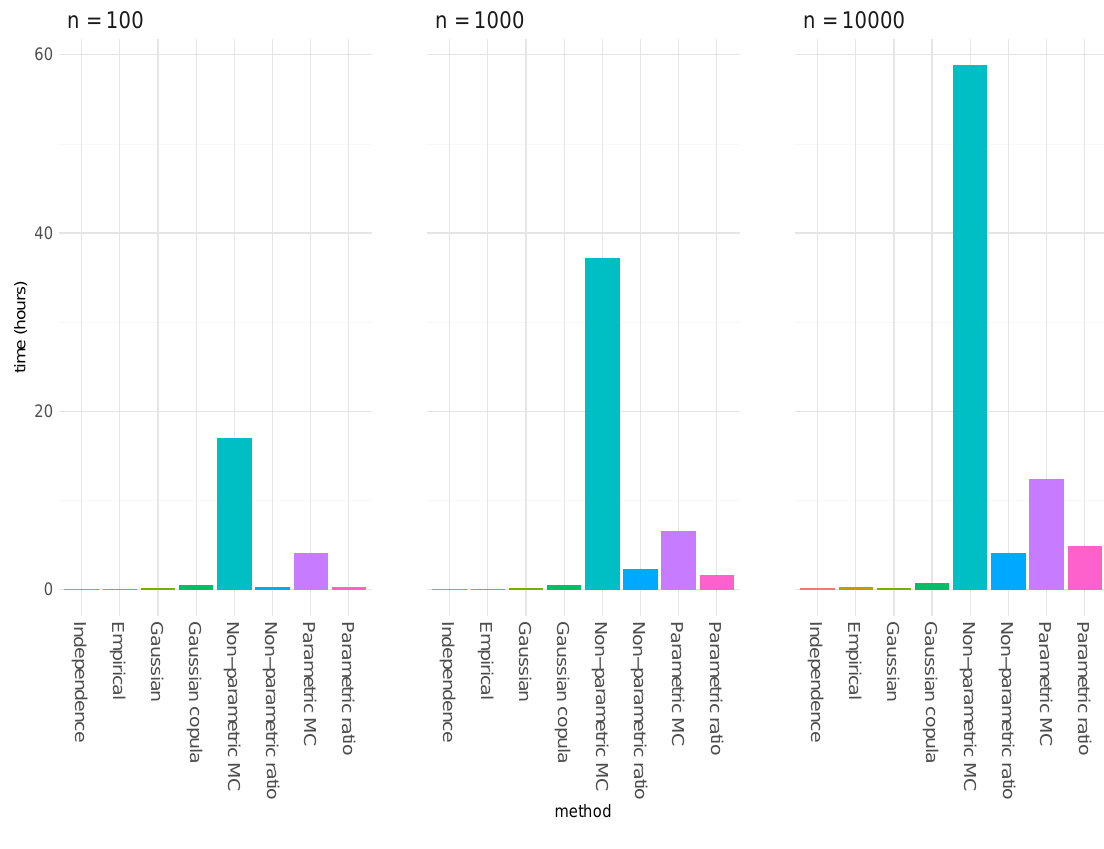
Figure 3: Average computation time (CPU hours) required for each sample size, method, on 100 test